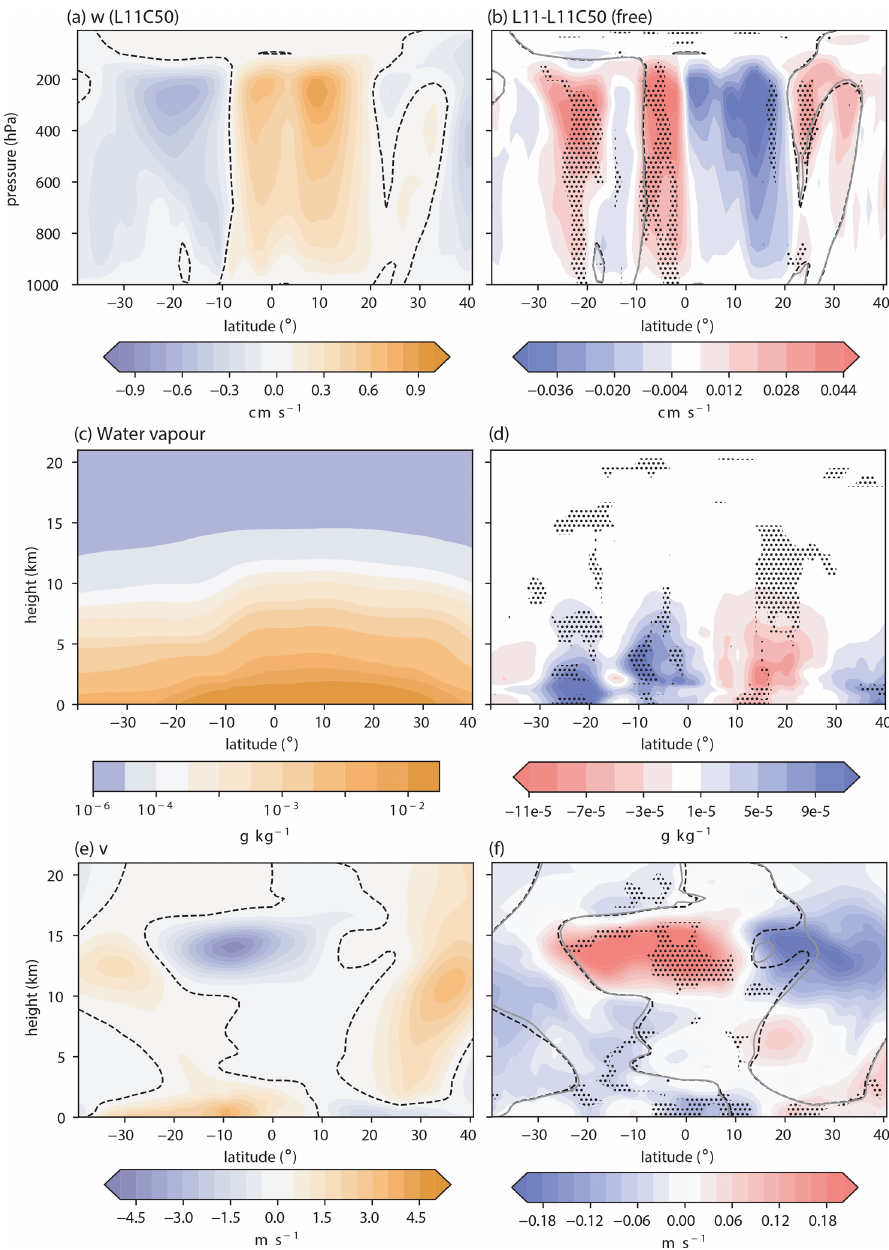
Figure 10. The zonal mean vertical profiles over the MC-Aus longitudinal region for vertical velocity ( w , a, b ) in centimetres per second (cms − 1 ), water vapour (c, d) in grams per kilogram (gkg − 1 ) and the v component of wind (e, f) in metres per second (ms − 1 ) for the free-running L11C50 simulation (a, c, e) and the difference in L11-L11C50 the free ensemble (b, d, f) , with the model agreement shown by stippling where at least five of the seven ensemble pairs agree in the sign of the difference. For panels (a) – (b) and (e) – (f) , the dashed black lines in all plots represent the zero contour of the L11C50 field, while in panels (b) and (f) the solid grey line indicates the zero contour of the L11